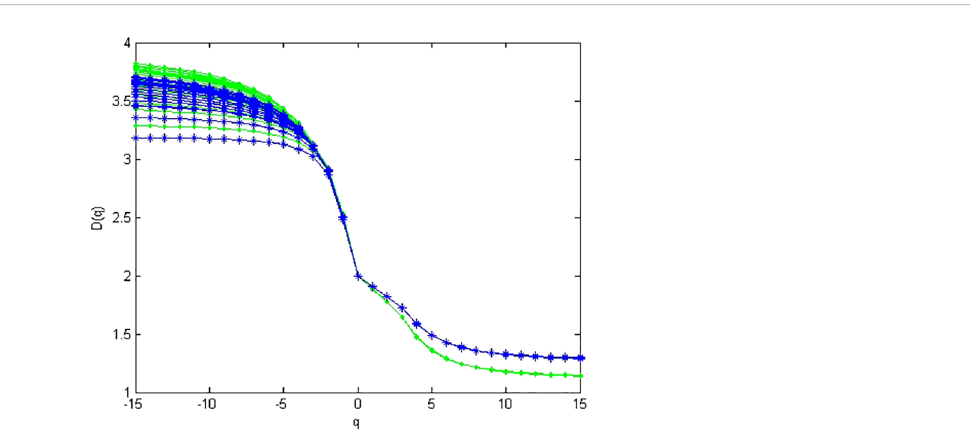
FIGURE 3 Multifractal dimensions of simulated genome. Green asterisks represented the D(q) of samples simulated from high-diversity communities, and blue dots represented the D(q) of samples simulated from low-diversity communities. For each sample from the same community, the abundances are given in Table S1 (the last line in the table).